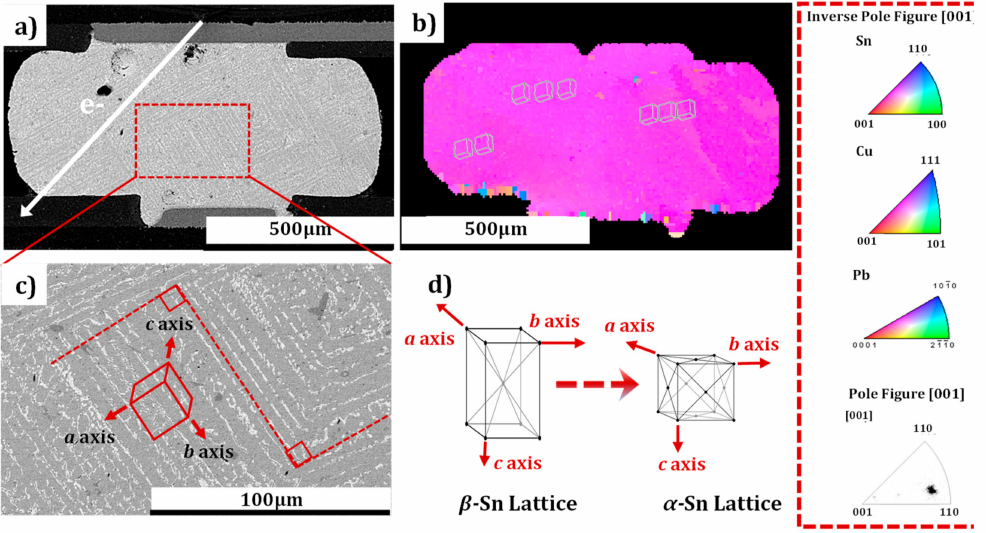
Figure 5. Microstructure images of the microbump with monocrystalline structure stressed at CT. ( a ) and ( c ) are SEM images of the SnPb (Pb content is 22.46%) microbump after stressing at the current density of 2.5 × 10 3 A / cm 2 for 100 h at CT ( − 196 ◦ C); ( b ) corresponding inverse pole figure of the microbump in Figure 3a; and ( d ) schematic diagram of the lattice structure transition from β -Sn (at RT) to α -Sn (at CT).